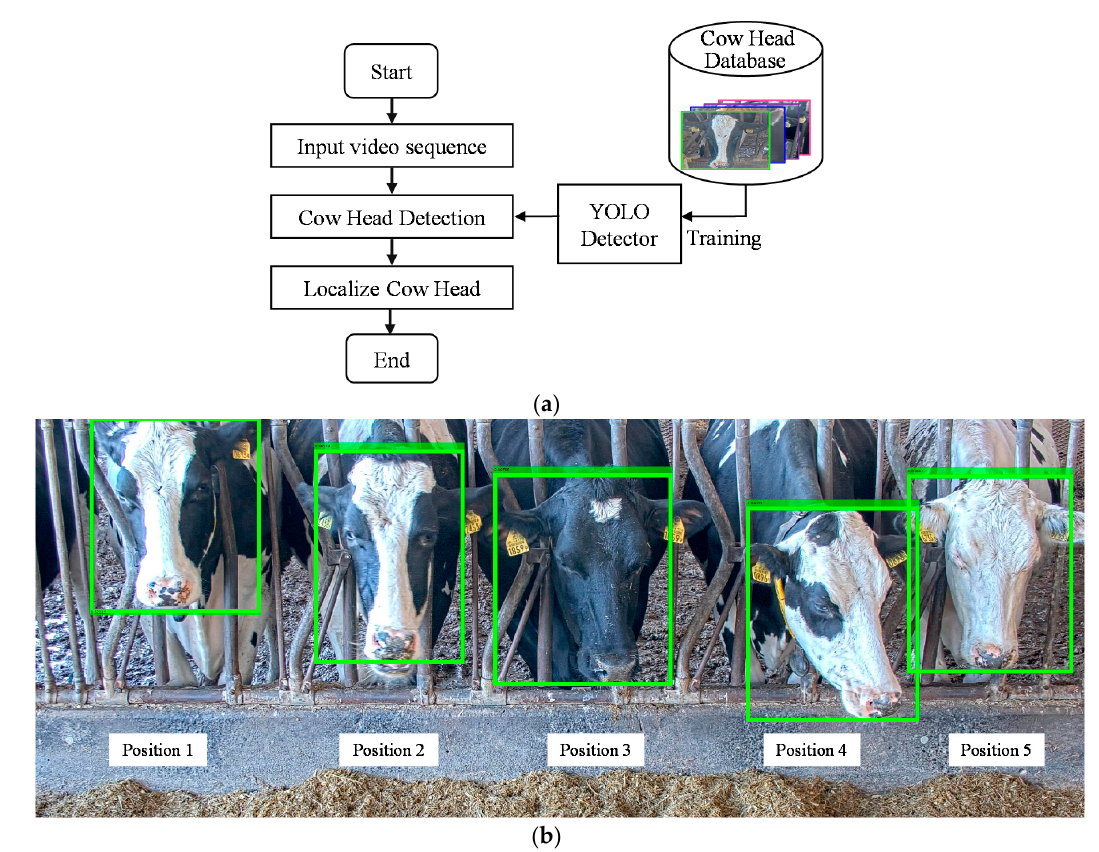
Figure 3. ( a ) Flowchart of cow head detection, ( b ) detected and localized cow heads.